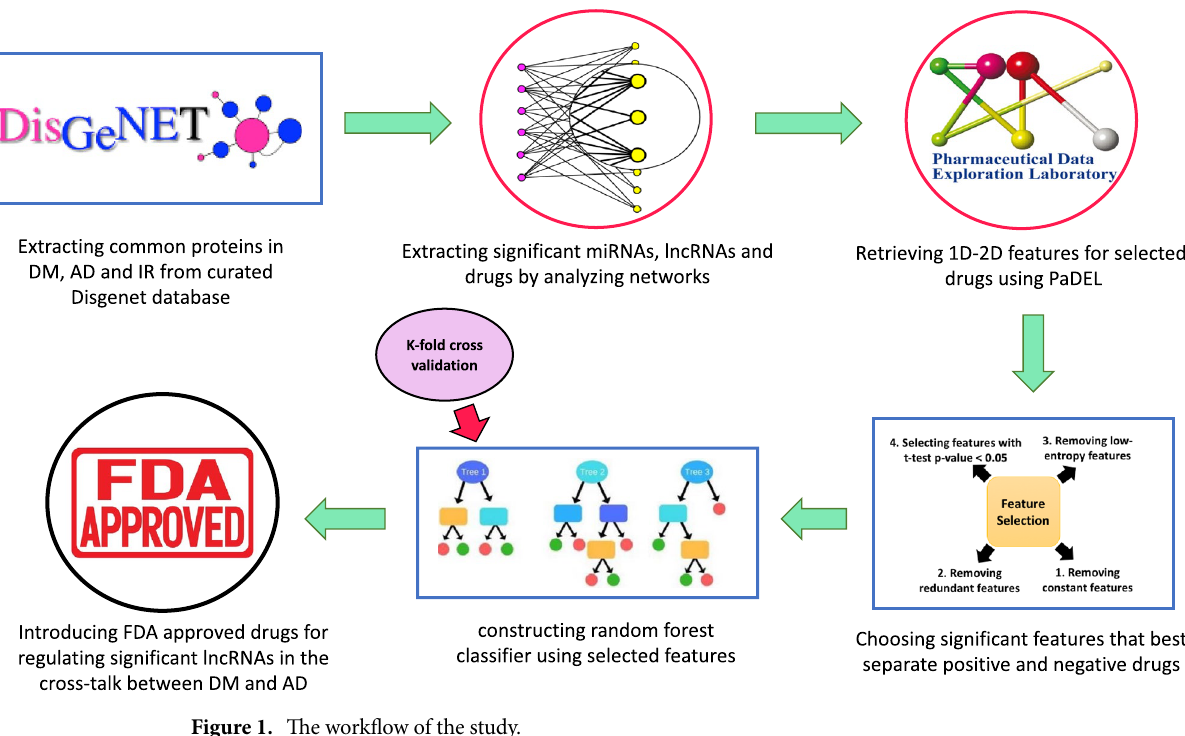
Figure 1. The workflow of the